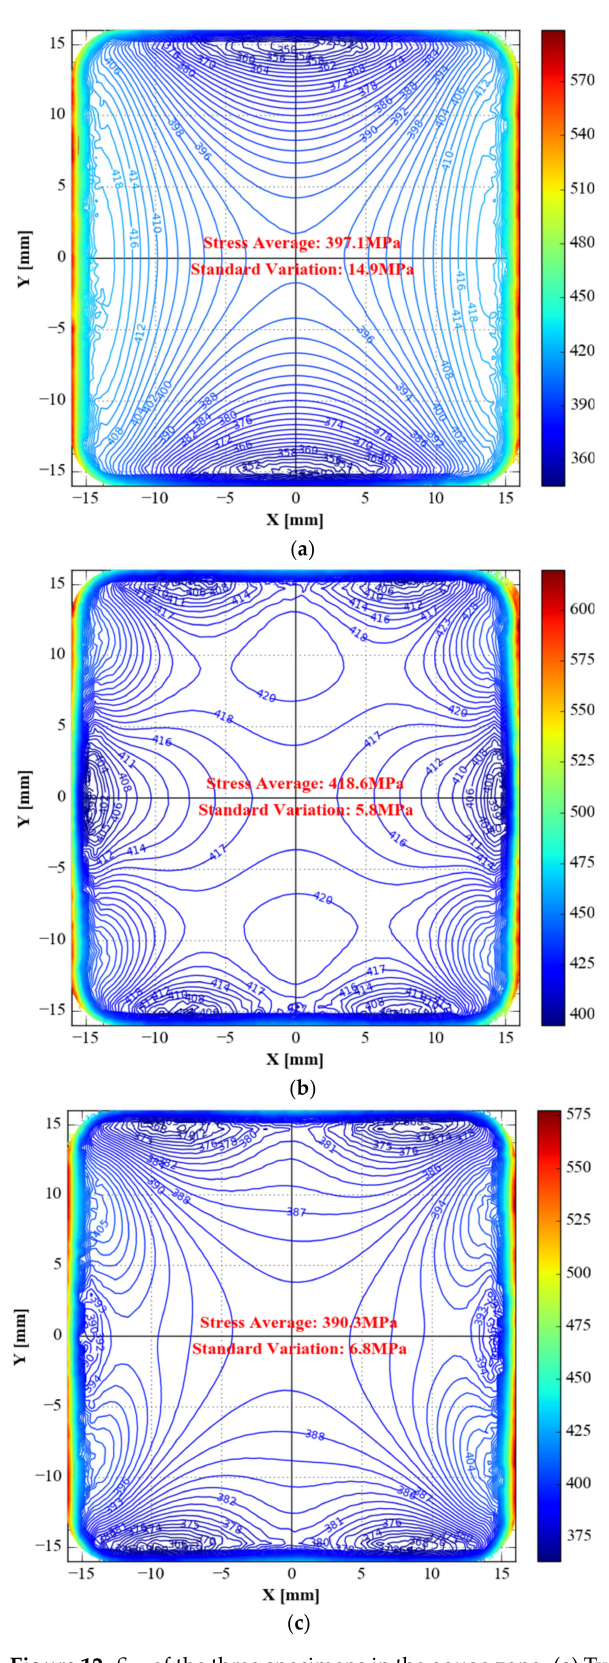
Figure 12. S 11 of the three specimens in the gauge zone. ( a ) Type A: unoptimised specimen; ( b ) type B: specimen with topology-only optimization; ( c ) type C: specimen with topology combined with shape